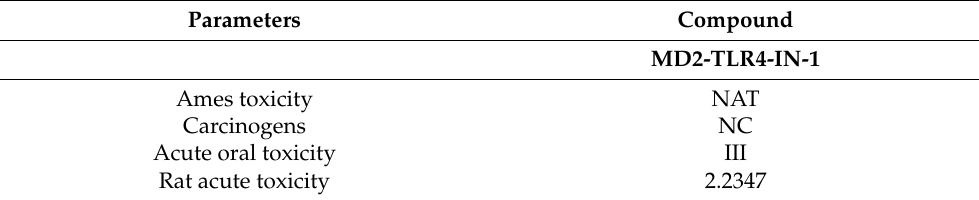
Table 4. A prediction of toxicological propensity of MD2-TLR4-IN-1 (PubChem ID: